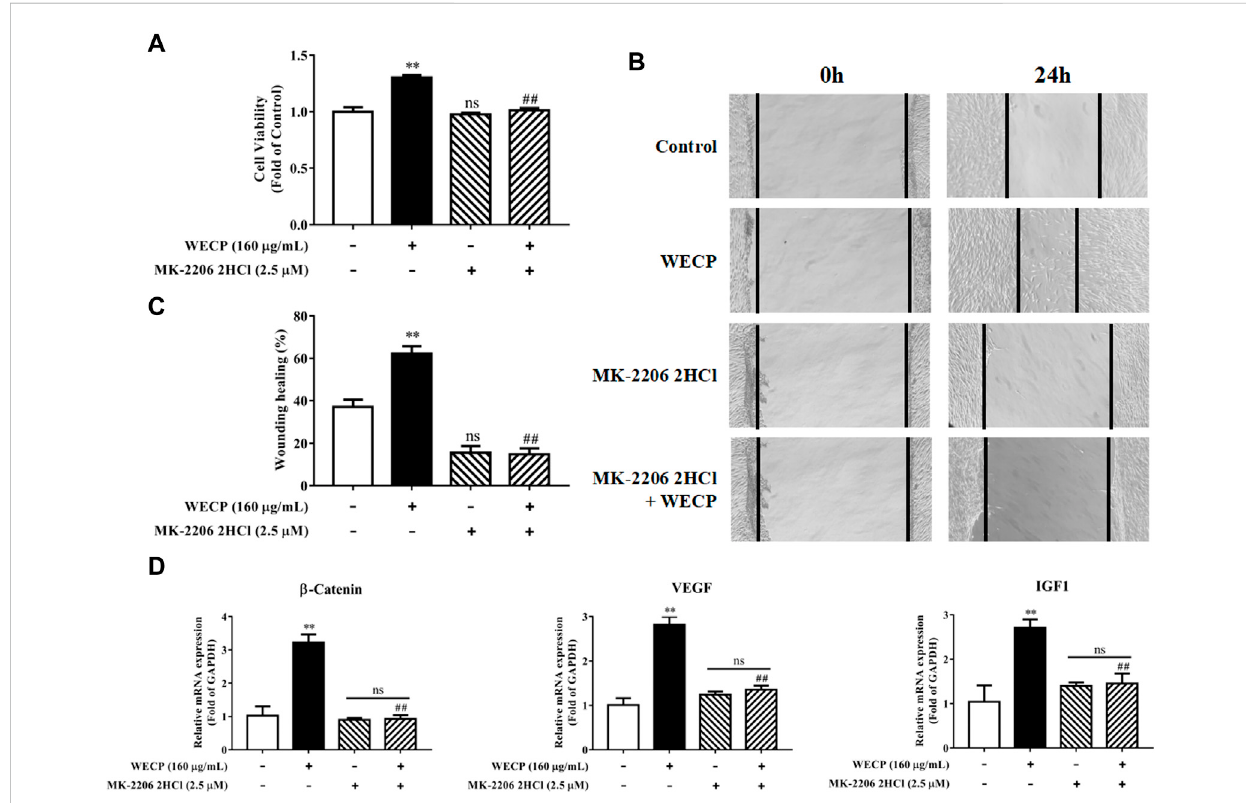
FIGURE 7 AbolitionofthepromotingeffectofWECPonDPC proliferation andmigrationthroughAktinhibition. (A – C) DPCsweretreatedwithWECP(160 μ g/ mL) for 24 h. Akt inhibitor MK-2206 2HCl was added 1 h before WECP treatment. (A) Cell proliferation was measured by CCK-8 assay. (B) Microscopic images of scratched areas were captured. Lines indicate migrating cell edges. (C) DPC migration was quantitatively analyzed and shown as bar graph. (D) Transcriptionalexpressionof β